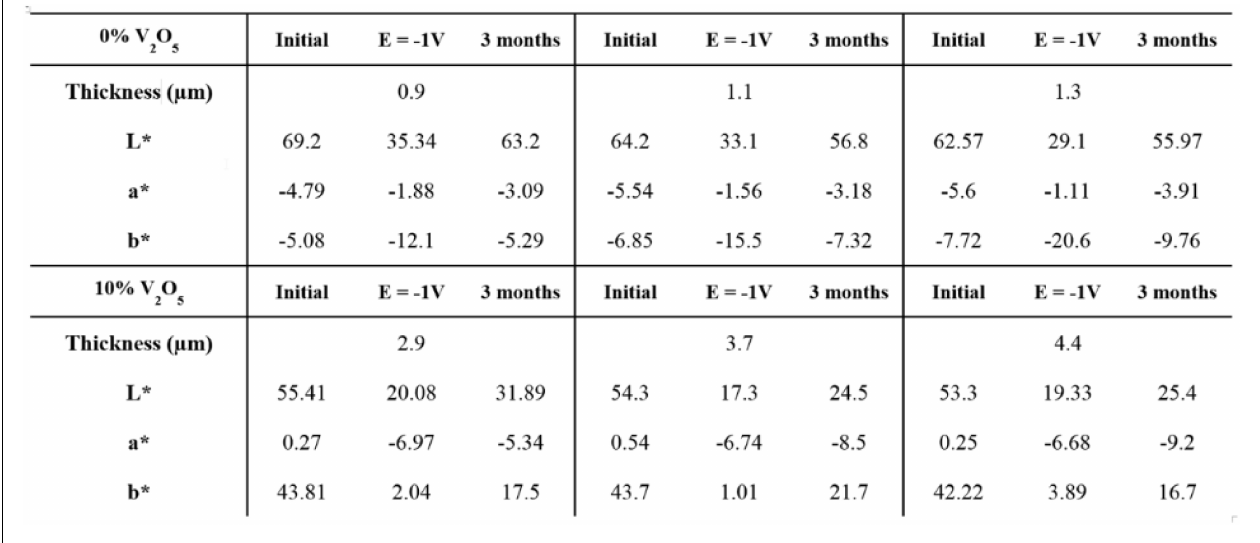
FIGURE 12 | Illustration of the memory-effect by comparison between the standard PEDOT:PSS and 90 wt%–10 wt% PEDOT:PSS-V 2 O 5 with chromaticity parameters taken at the initial stage, at E = –1 V and after 3 months after applying first E = –1 V, leaving the samples rest at room temperature and ambient atmosphere without any cycle in